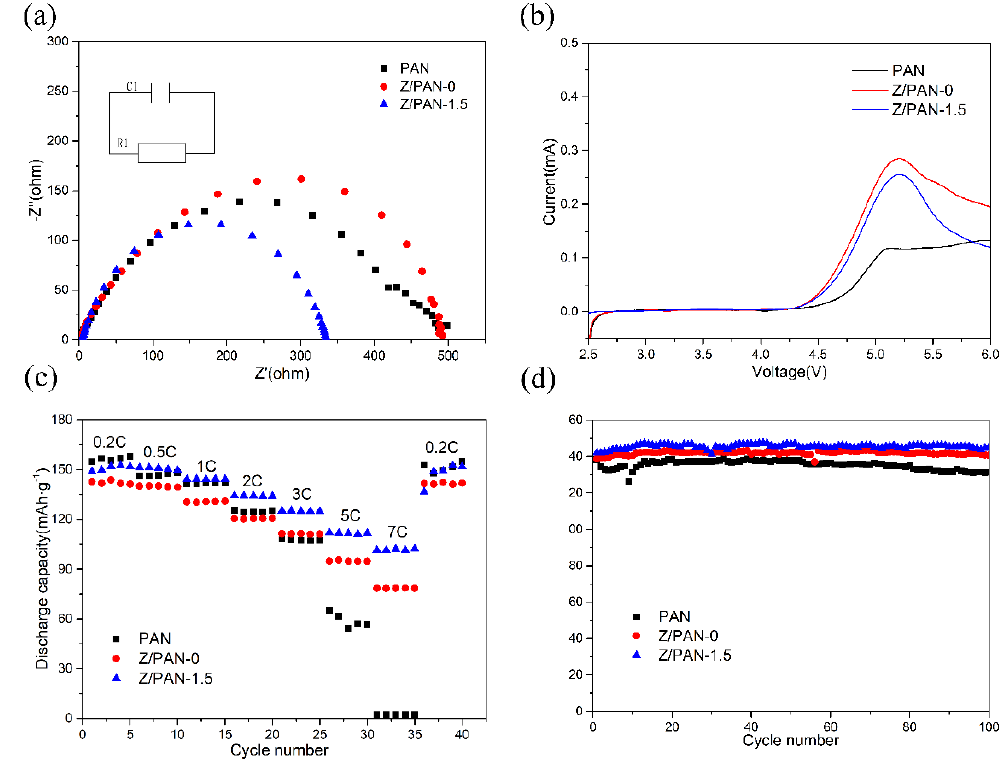
Figure 8. ( a ) The interfacial AC impedance spectra of cells assembled with different separators; ( b ) Linear scan voltammograms (LSV) curves of different separators; ( c ) Rate capability of the cells with different separators at the current densities range from 0.2 C to 7 C; ( d ) Cycle performance of the cells with different separators under 0.5 C.